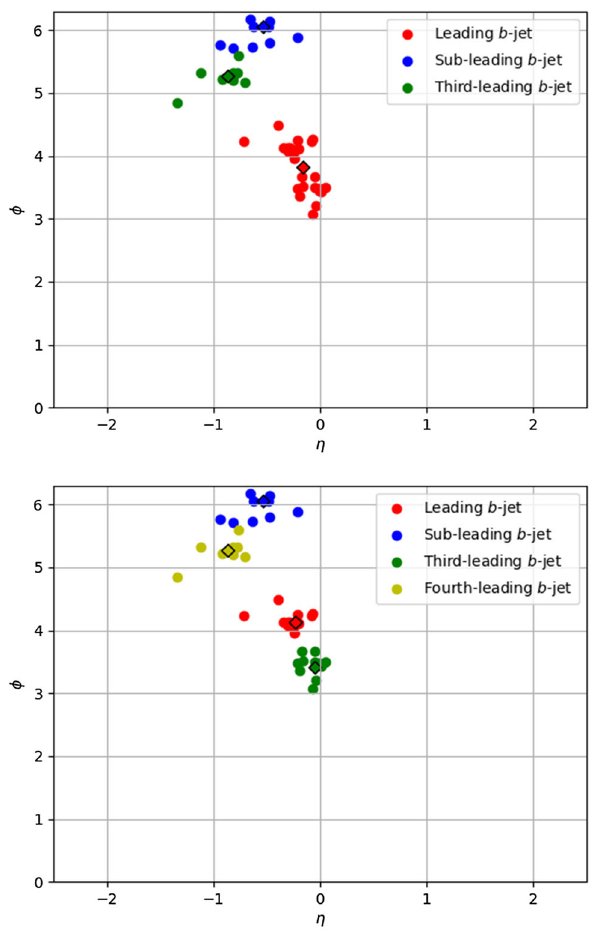
Fig. 3 As in Fig. 2, a different event is clustered with a fixed R = 0 . 8 (upper) and the variable R algorithm (bottom). This results in the formation of three b -jets for fixed R (upper) and four b -jets for the variable- R algorithm